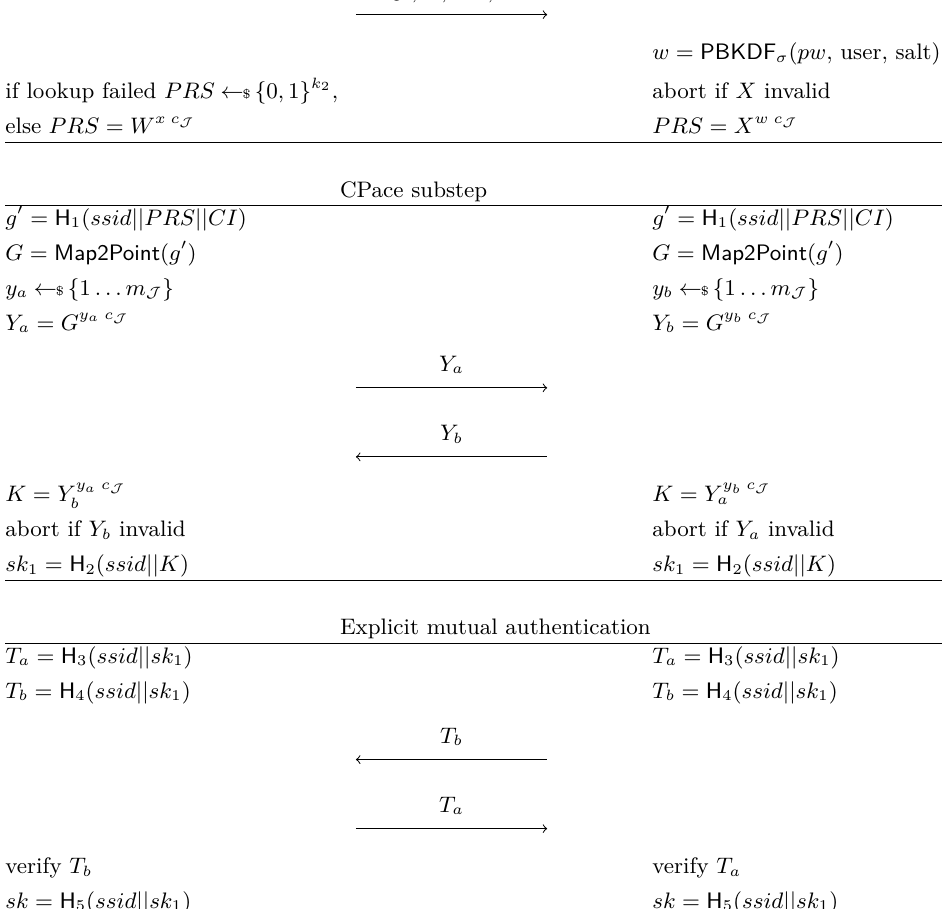
Figure 4: Protocol